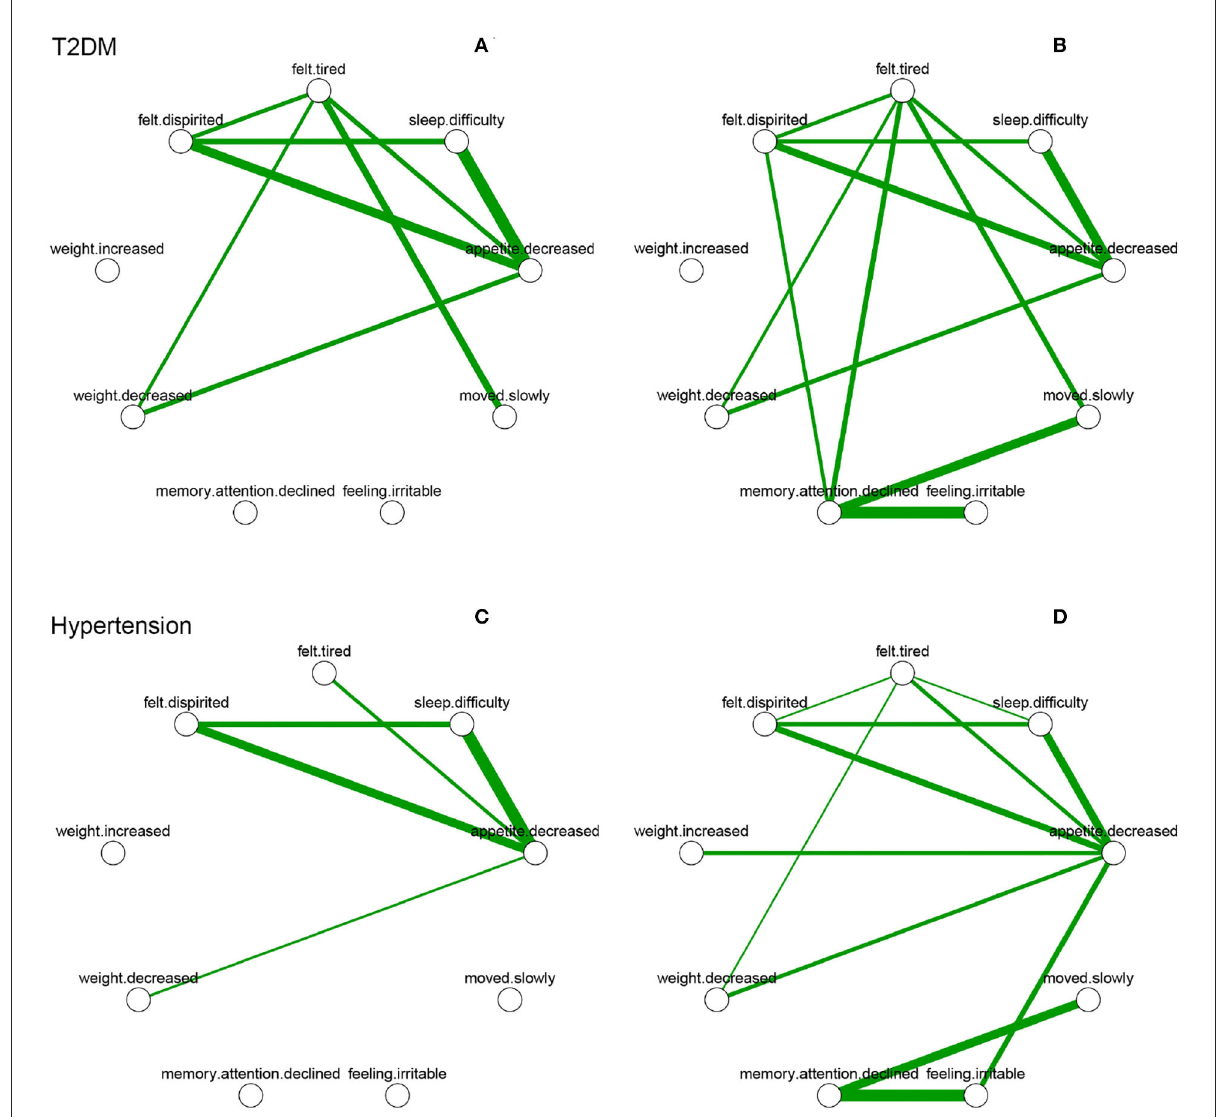
FIGURE2 Depressive symptom networks within 2 years before and after the diagnosis of T2DM and hypertension. Green lines represent positive association, and thicker lines represent stronger association. (A) is within 2 years before diagnosed date of T2DM. (B) is within 2 years after diagnosed date of T2DM. (C) is within 2 years before diagnosed date of hypertension. (D) is within 2 years after diagnosed date of